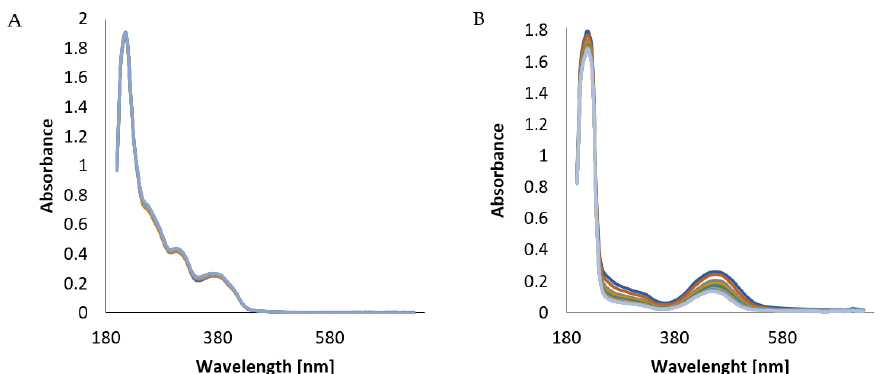
Figure 8. UV-Vis spectra of compounds: ( A ) 2d and ( B ) 2b in 0.1% DMF/PBS solution (pH 7.4) at a concentration of 40 μ M and 37 °C.